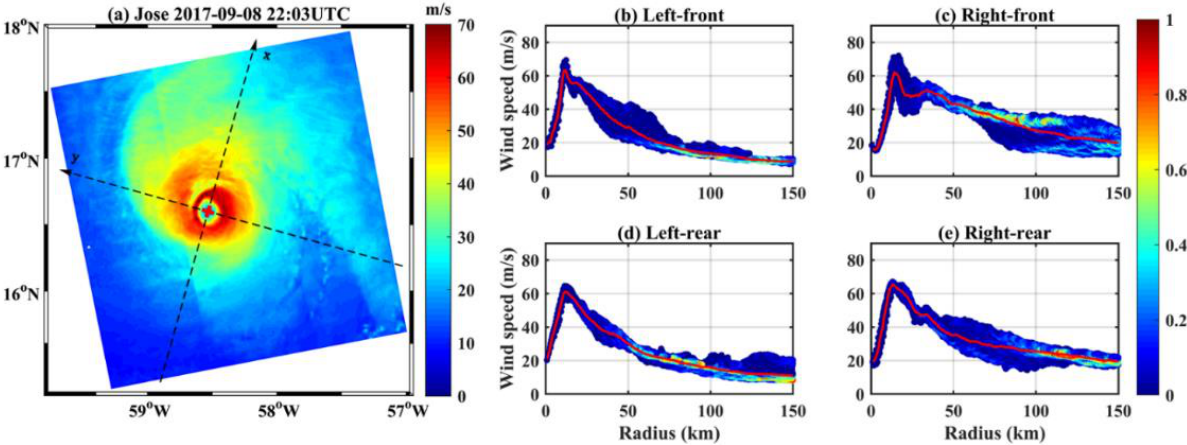
Figure 15. The same as Figure 11 but for Hurricane Jose at 22:03 UTC on 8 September 2017.